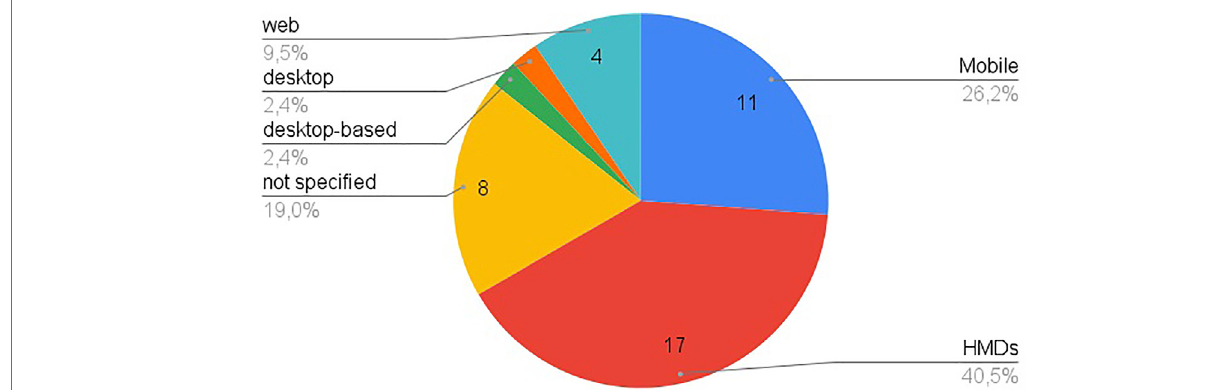
FIGURE 3 | Focused devices in the selected articles.